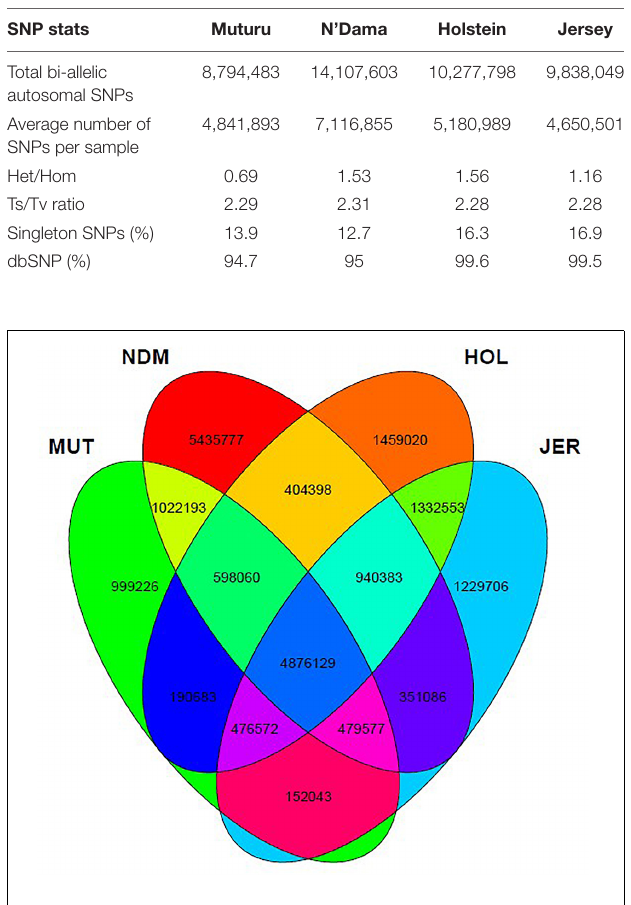
FIGURE 1 | Venn diagram of unique and shared autosomal bi-allelic SNPs between Muturu and other taurine. MUT, Muturu; NDM, N’Dama; HOL, Holstein; JER,